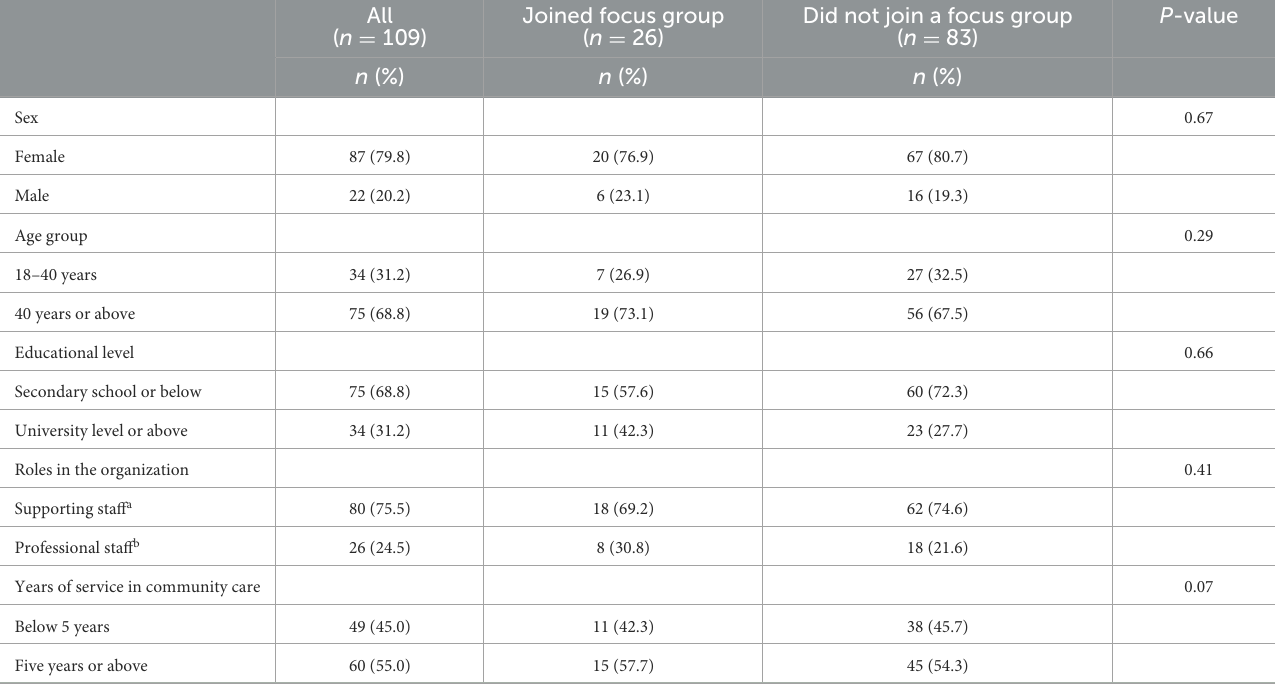
TABLE 3 Characteristics of survey participants.